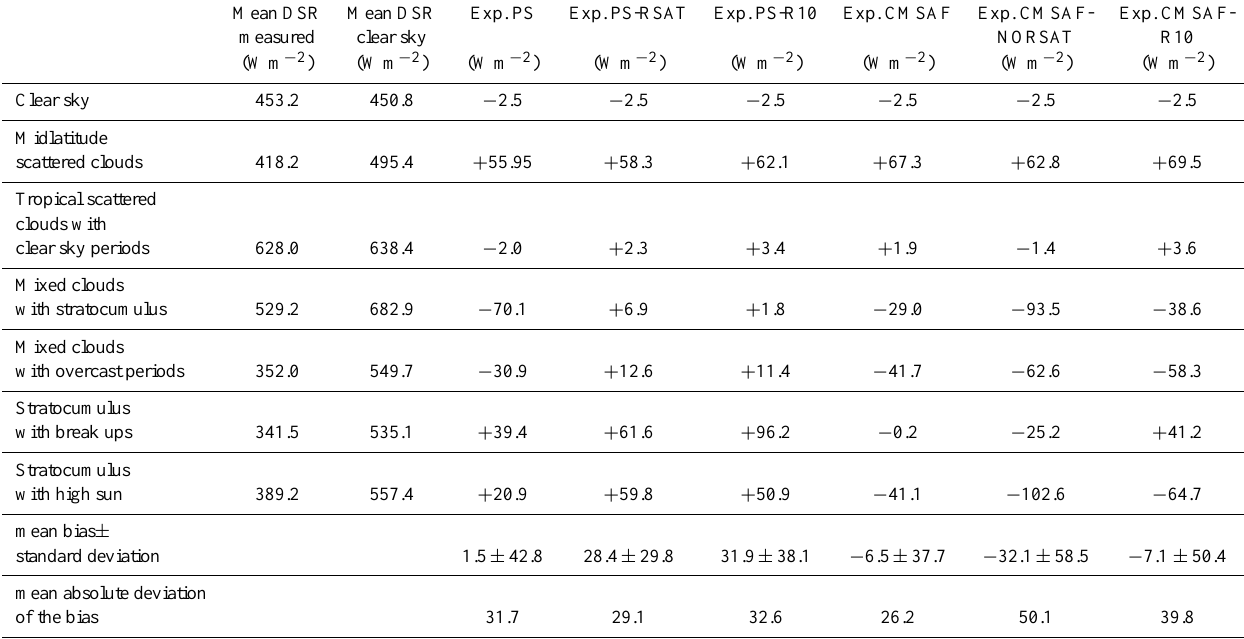
Table 3. Results of the six experiments applied to seven different atmospheric conditions examined within this study are shown as deviations of the modeled to the measured daily mean DSR(bias). Additionally the measured and parameterized clear sky DSR at the surface is given inWm − 2 . The parametrization is taken from Kalisch and Macke (2008). In the last two rows the mean bias and the mean absolute deviation of the bias over all cases and for each experiment is shown inWm − 2